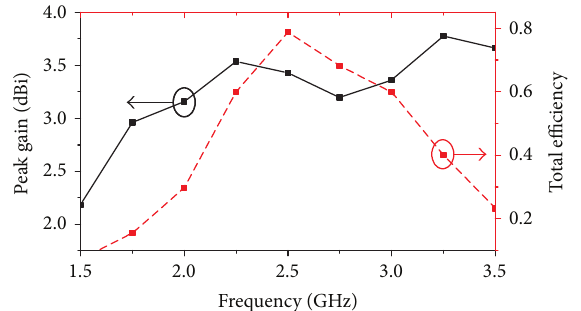
Figure 10: The measured peak gain and the total efficiency varia- tions of Notch